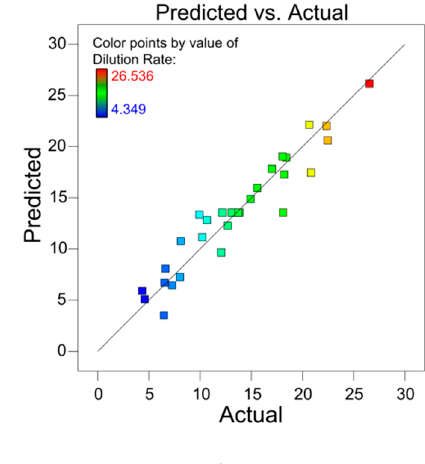
Figure 13. ( a ) Dilution rate model plot of residuals. ( b ) Dilution rate model prediction and actual comparison.